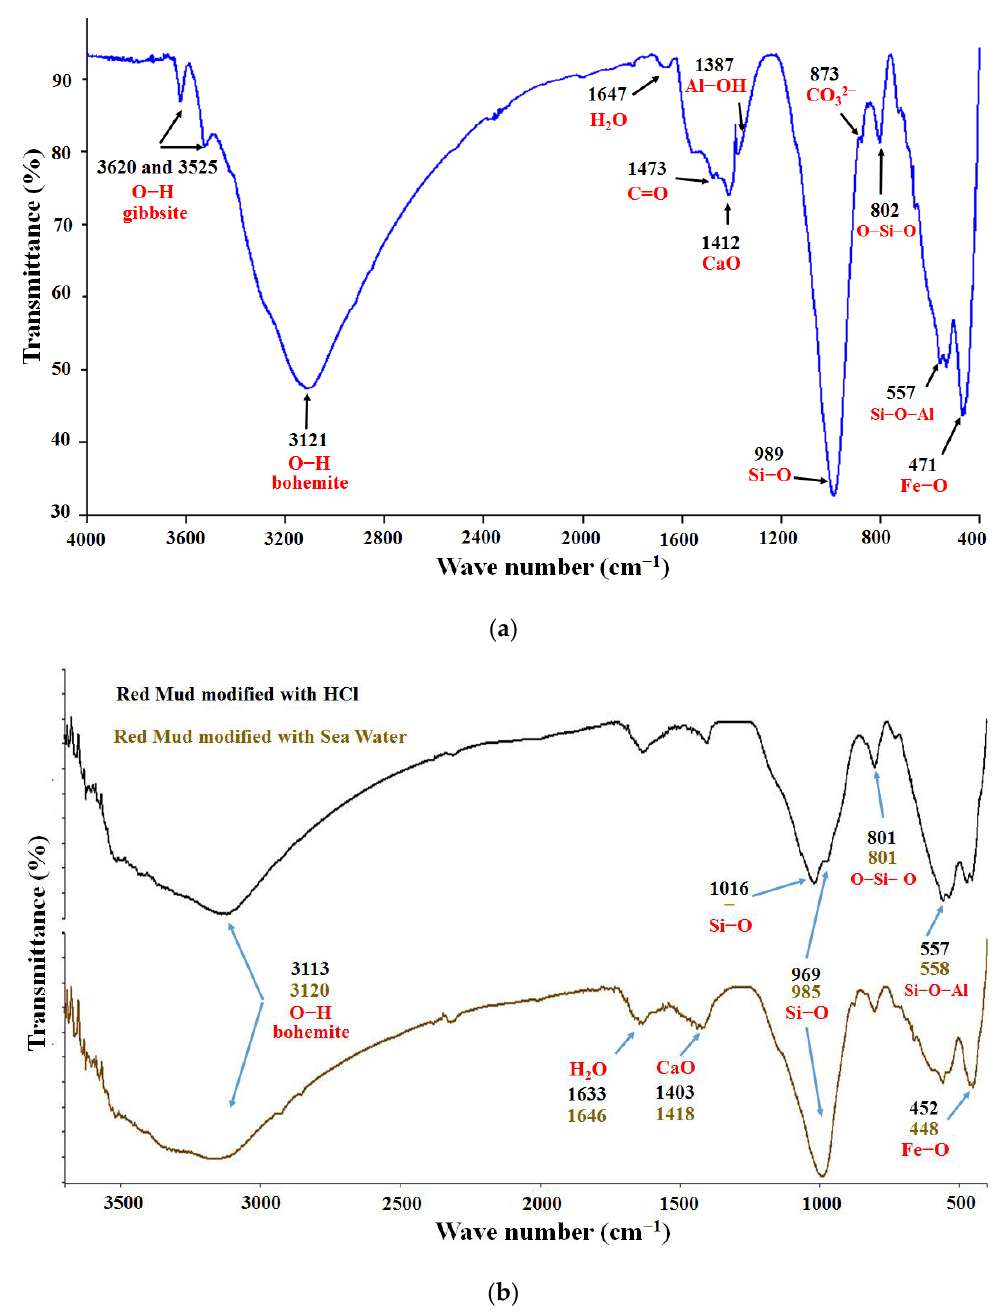
Figure 2. FTIR spectrum of the red mud ( a ) without modification, ( b ) after modifications with seawater and HCl solution.